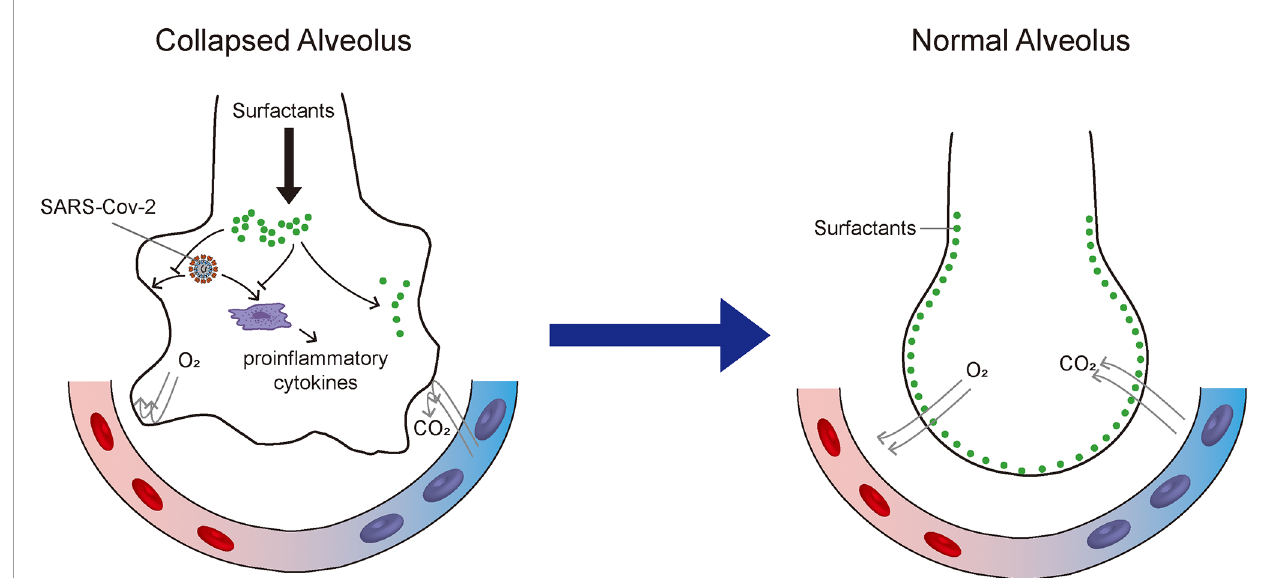
FIGURE 1 | Therapeutic mechanisms of exogenous pulmonary surfactant for SARS-CoV-2 infection. Pulmonary surfactant can (1) mitigate acute respiratory distress syndrome by reducing alveolar surface tension and improving pulmonary mechanical properties; (2) suppress pro-in fl ammatory cytokine secretion; and (3) potentially inhibit SARS-CoV-2 replication and restrict SARS-CoV-2